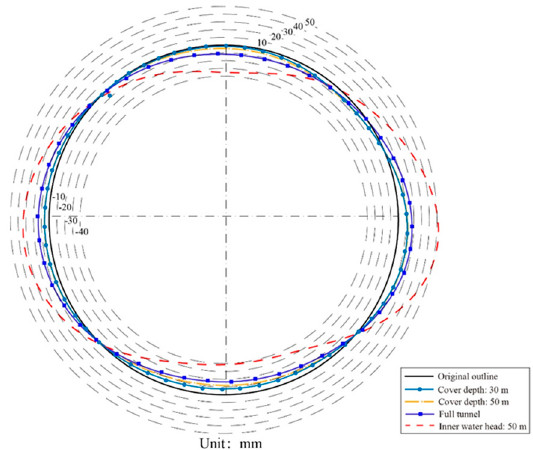
Figure 11. The full-ring deformation contours of the circular tunnel under different loading conditions obtained by TLS.